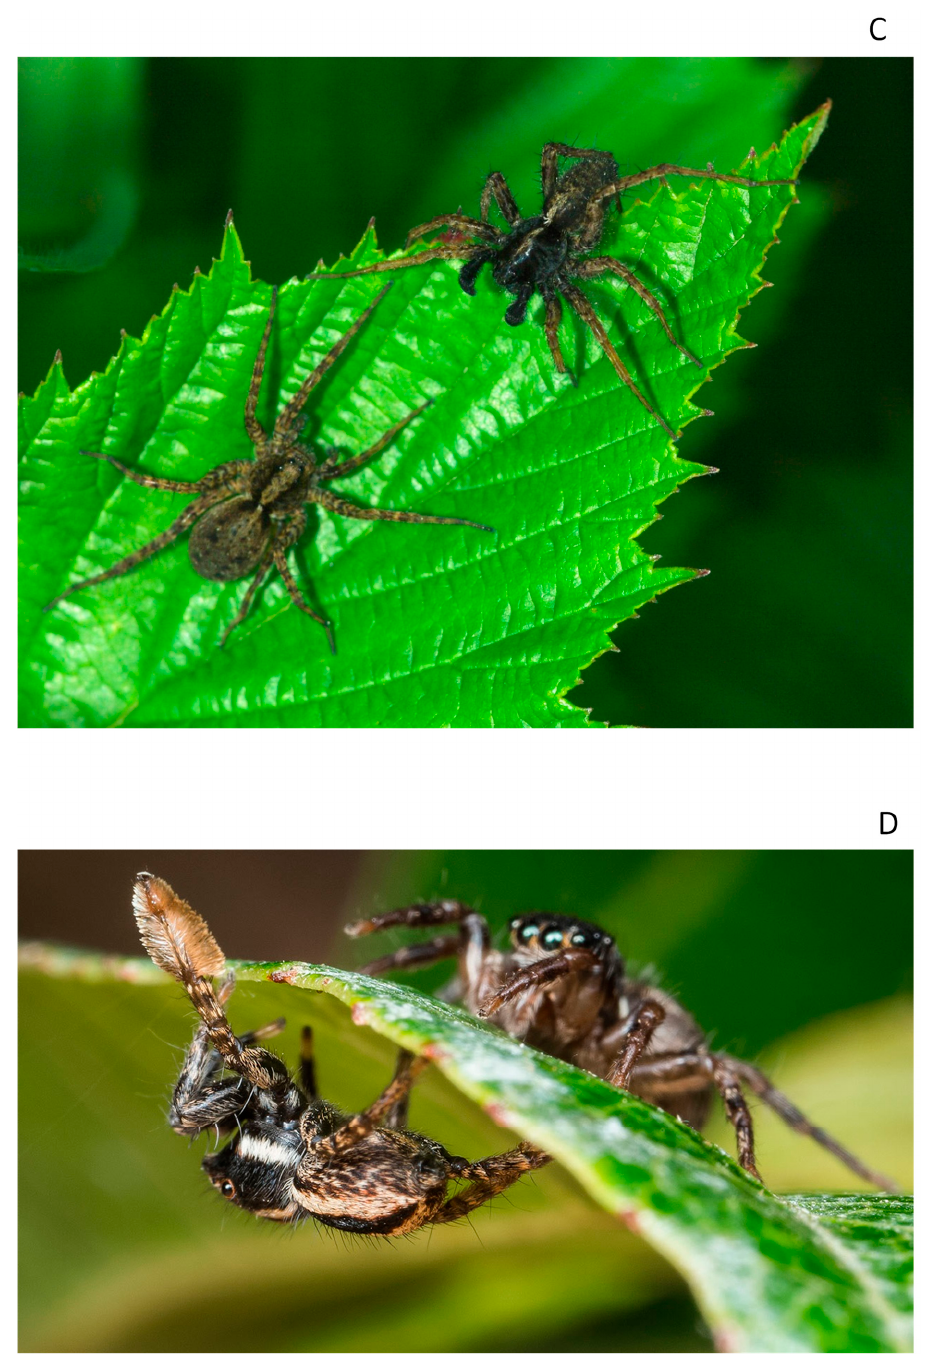
Figure 1. Photographs showing immense variability in the degree of sexual size dimorphism in spiders. ( A ) Giant golden orb-weaver, Nephila pilipes (Araneidae), adult male (orange) about to mate with a much larger adult female. ( B ) Adult male (left) courting a much larger adult female (right) of the brown widow spider, Latrodectus geometricus (Theridiidae). ( C ) Adult male (upper right) and adult female (lower left) of the spotted wolf spider, Pardosa amentata (Lycosidae), illustrating similarity in body size. ( D ) Adult male (under leaf, left) and adult female (upper leaf, right) of the jumping spider Jotus remus (Salticidae) The male is similarly sized with the female and uses a fan-like structure on the tarsi of the third right leg to signal females of its